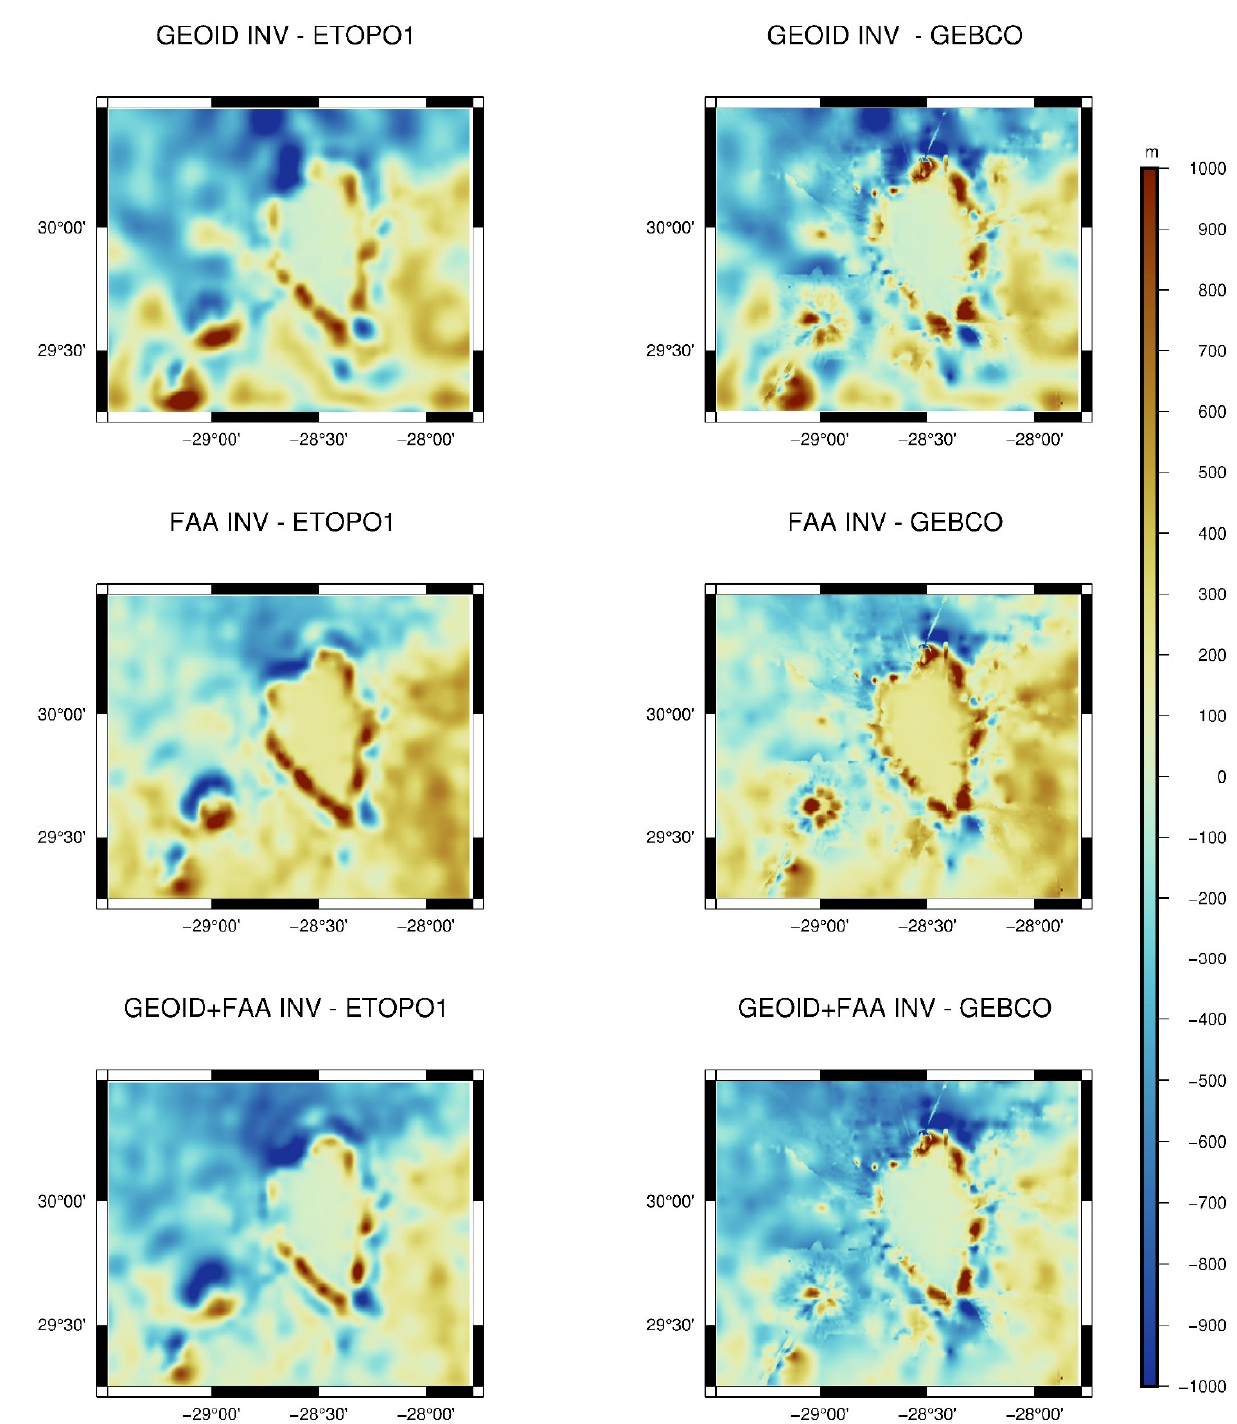
Figure 10. Differences between EKF solutions and ETOPO1 (left) and GEBCO grids (right). Units are meters.